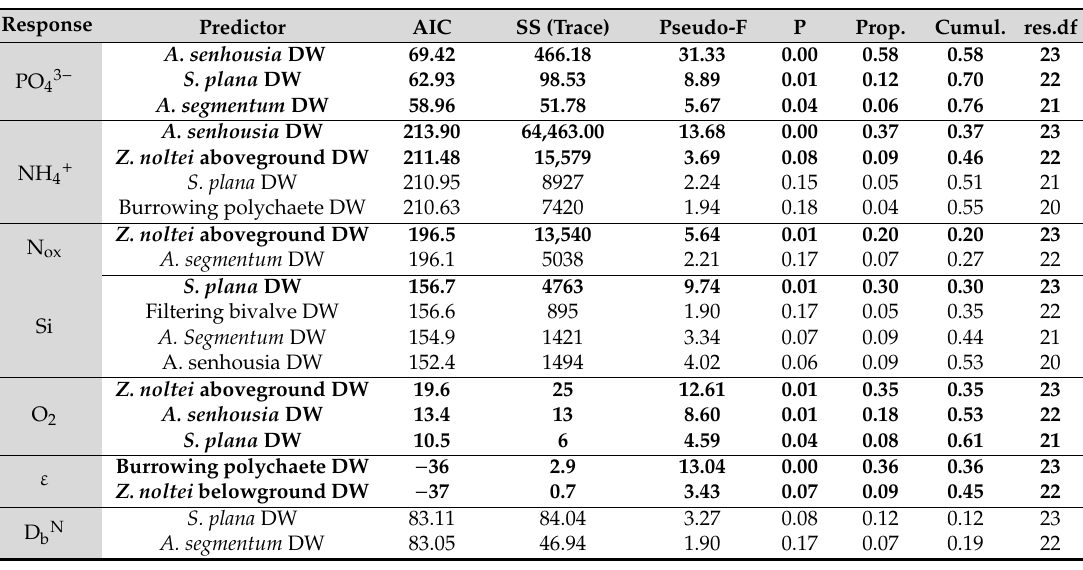
Table 2. Sequential distance-based linear models result between predictors (macrofauna and environment) and response variables (benthic fluxes across the sediment water interface (PO 43 − , NH 4 + , NO x , Si, and O 2 ) and community bioturbation rates (particle mixing normal biodi ff usion the forward selection procedure and AIC selection criterion. Bold font indicates significant results ( p < 0.05).